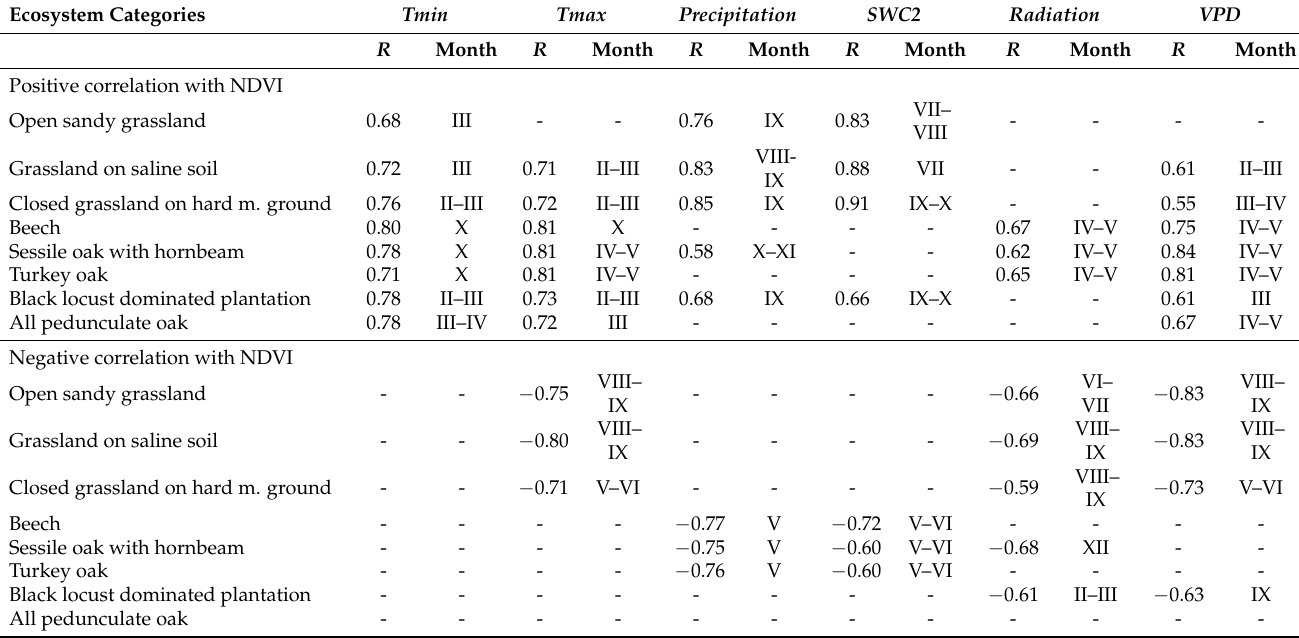
Table 2. Maximum and minimum significant ( p ≤ 0.01) R -values representing the correlation between NDVI and the climate variables used during the year, based on the first R -curve (see also Figure 5). The months associated with the maximum and minimum significant R -values are also indicated, referring to the 32-day long period of the investigated vegetation state. The R -value with the greatest absolute value of each climate variable is marked in bold. In the case of no significant correlation ( p > 0.01), the R -values are not